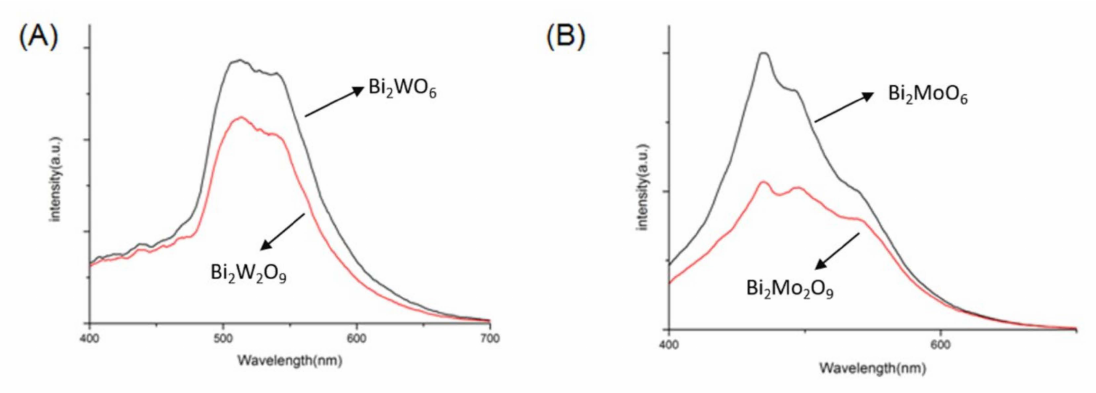
Figure 10. Photoluminescence (PL) spectra of ( A ) Bi 2 WO 6 and Bi 2 W 2 O 9 ; ( B ) Bi 2 MoO 6 and Bi 2 Mo 2 O 9